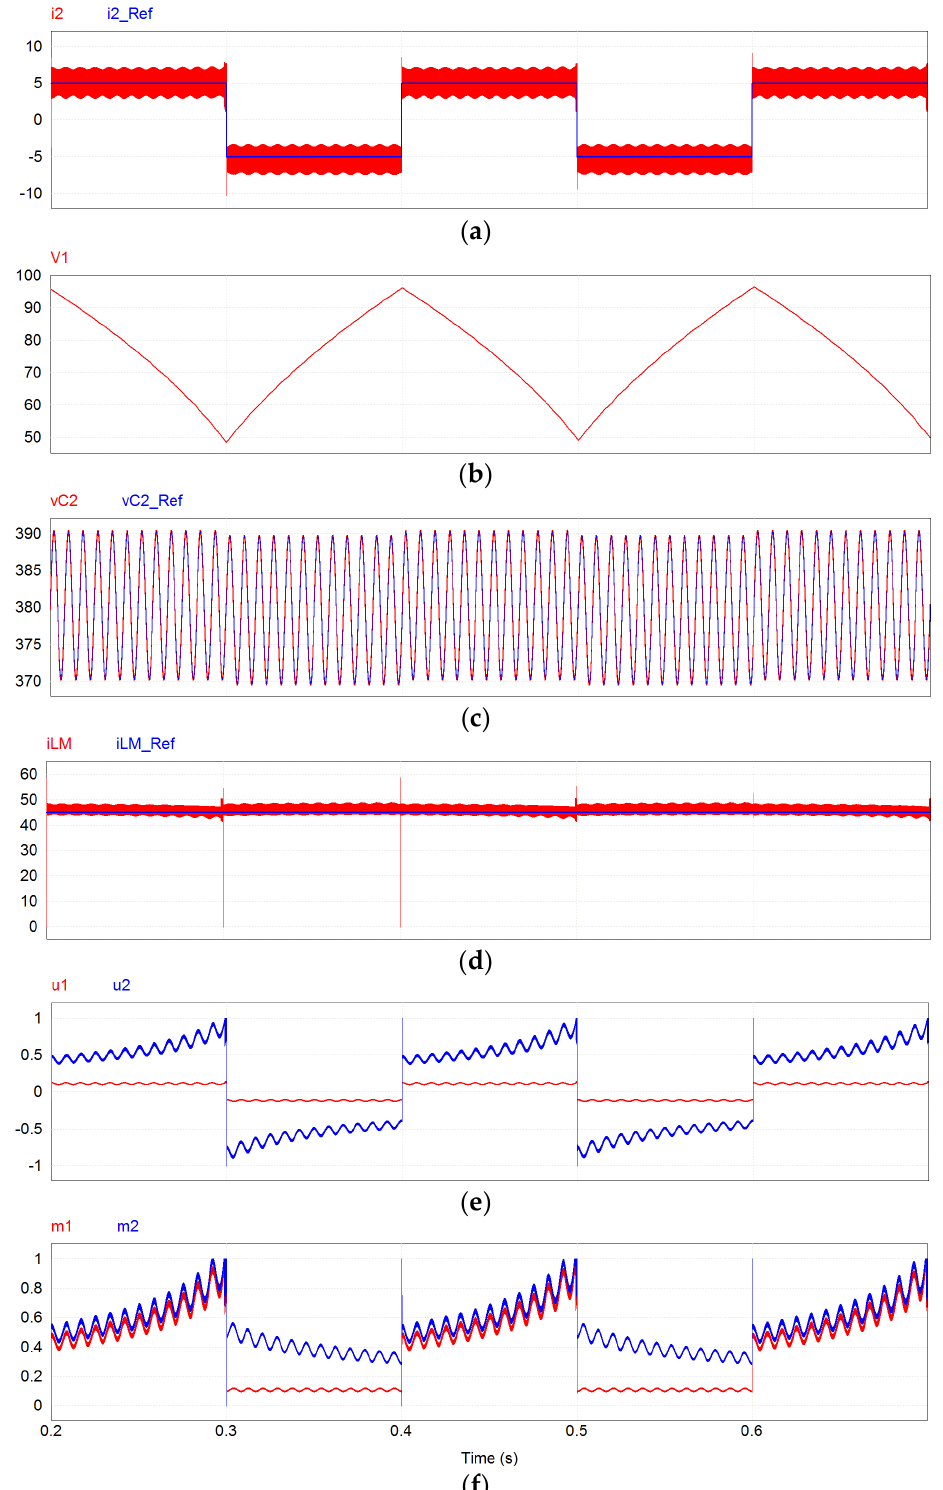
Figure 16. Waveforms for the tri-state buck–boost control with state feedback linearization for test 3. ( a ) Reference and output current (in A), ( b ) voltage at Bus 1 (in V), ( c ) reference and output capacitor voltage (in V), ( d ) reference and inductor current (in A), ( e ) non-linear control variables, ( f ) PWM modulation